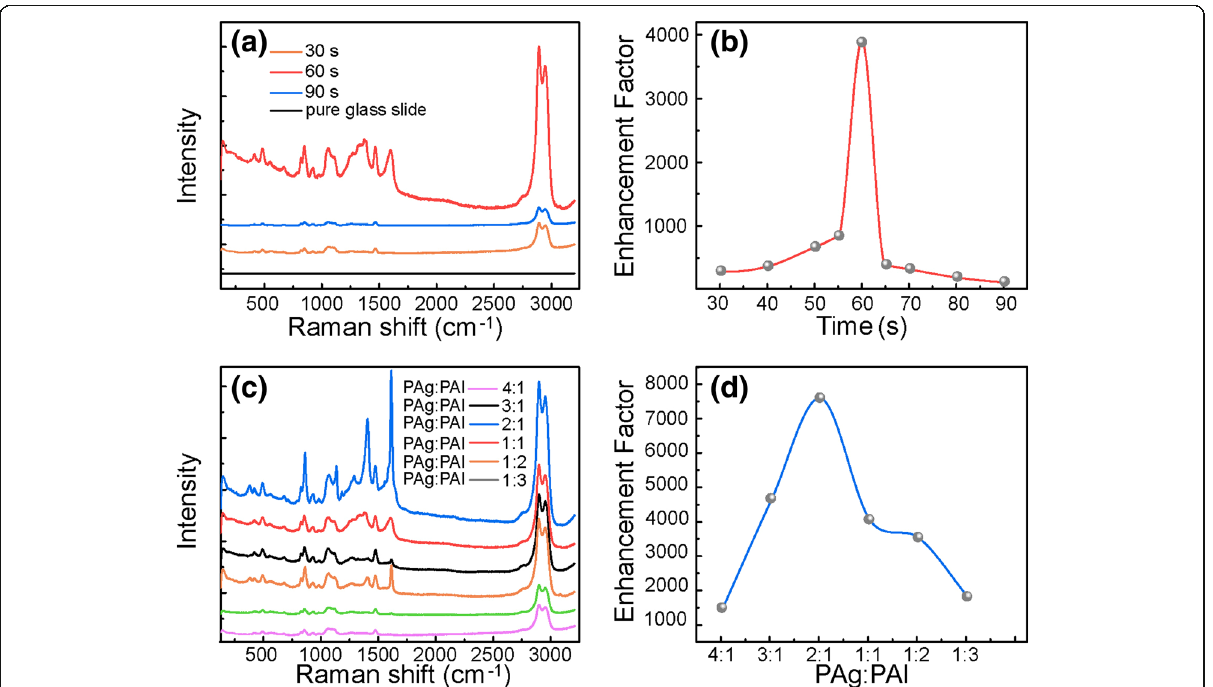
Fig. 2 The SERS spectra of glycerin collected on substrate prepared with different (Ag, Al) co-sputtering time ( a , b ) and power ratio ( c , d ) without TiO 2